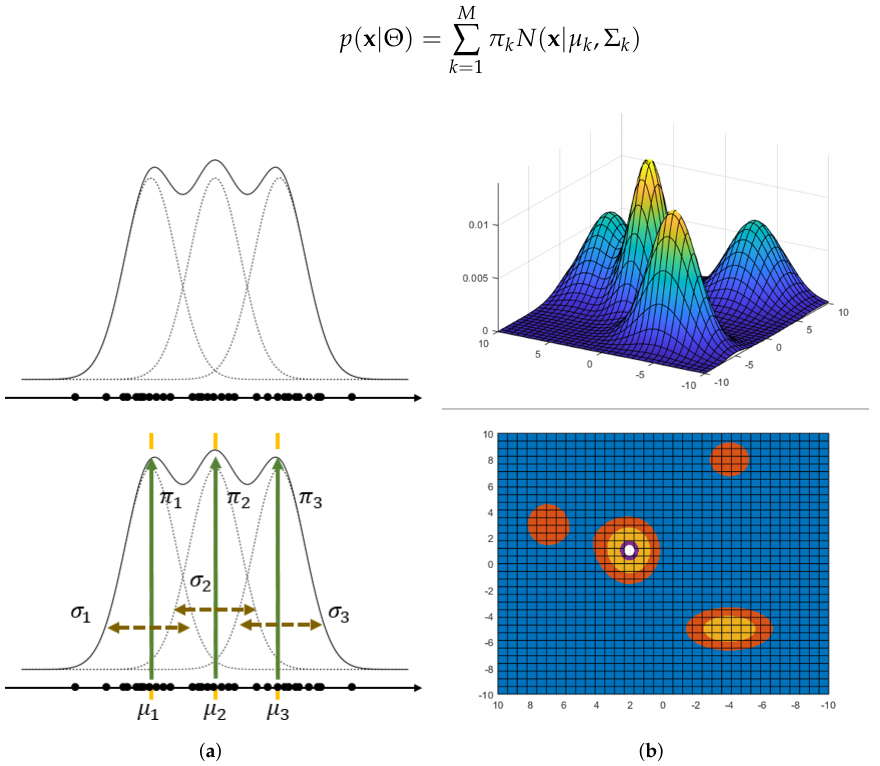
Figure 1. Examples of GMM. ( a ) GMM based on 1D data; ( b ) GMM and ellipses based on 2D